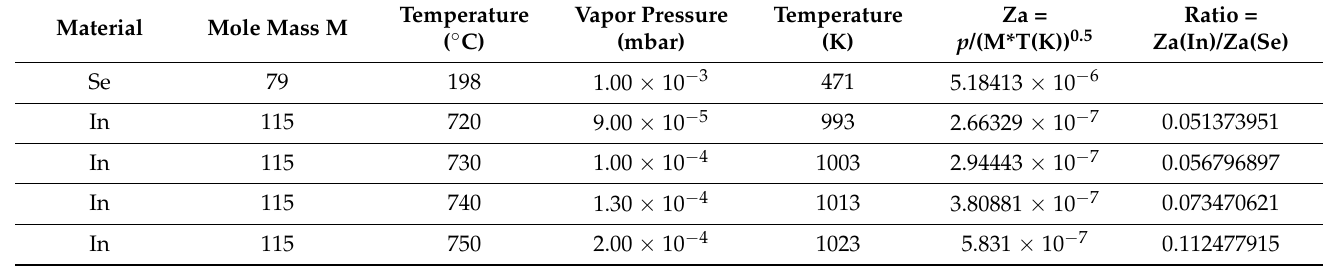
Table A1. The In/Se ratio calculation referenced from the formula of evaporation rate of the materi- als [37].